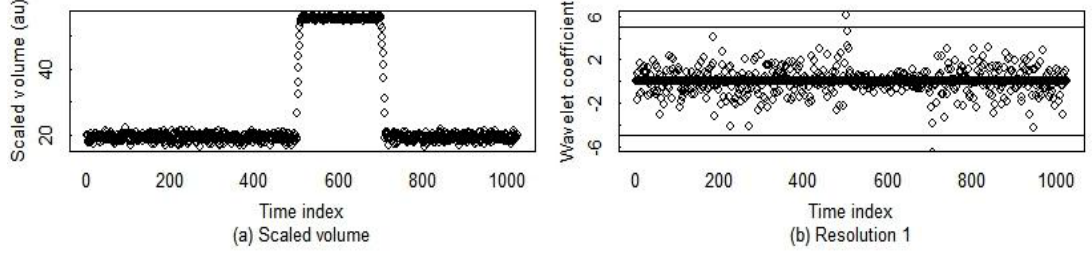
Figure 3. Simulated scaled volumes for one tank cycle and the wavelet coefficients at each of five resolutions. Horizontal threshold lines at ±5 are included. Resolution 4 or 5 work well for this example and for similar examples because the threshold can be selected to find only one outlier in the receipt change region and one outlier in the shipment change region. Plot ( a ) is the scaled volume versus the time index. Plots ( b )–( f ) are the corresponding wavelet coefficients at 5 different